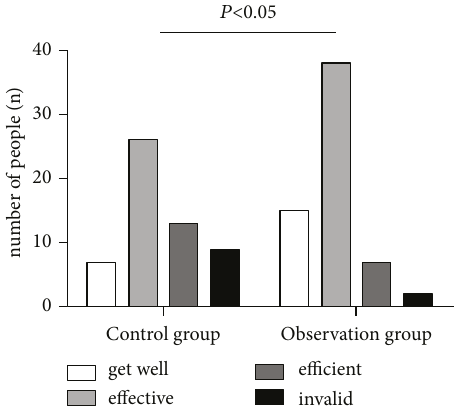
Figure 1: Comparison of clinical efficacy between the two groups. Table 2: Comparison of anxiety scores and sleep quality between the two groups of patients ( x ± s , points).